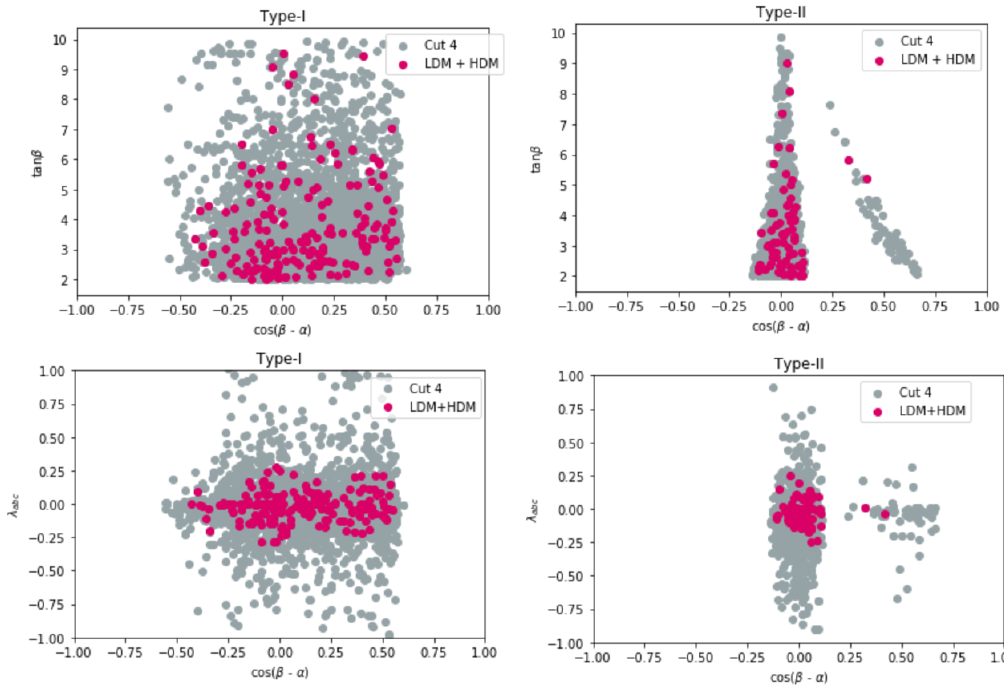
Figure 2 . Parameter space points in the cos ( (cid:12) (cid:0) (cid:11) )-tan (cid:12) (upper) and cos ( (cid:12) (cid:0) (cid:11) )- (cid:21) abc (lower) planes. All points survived the cut 4 of the parameter scan while the green dots are also compliant with Planck lower limit.